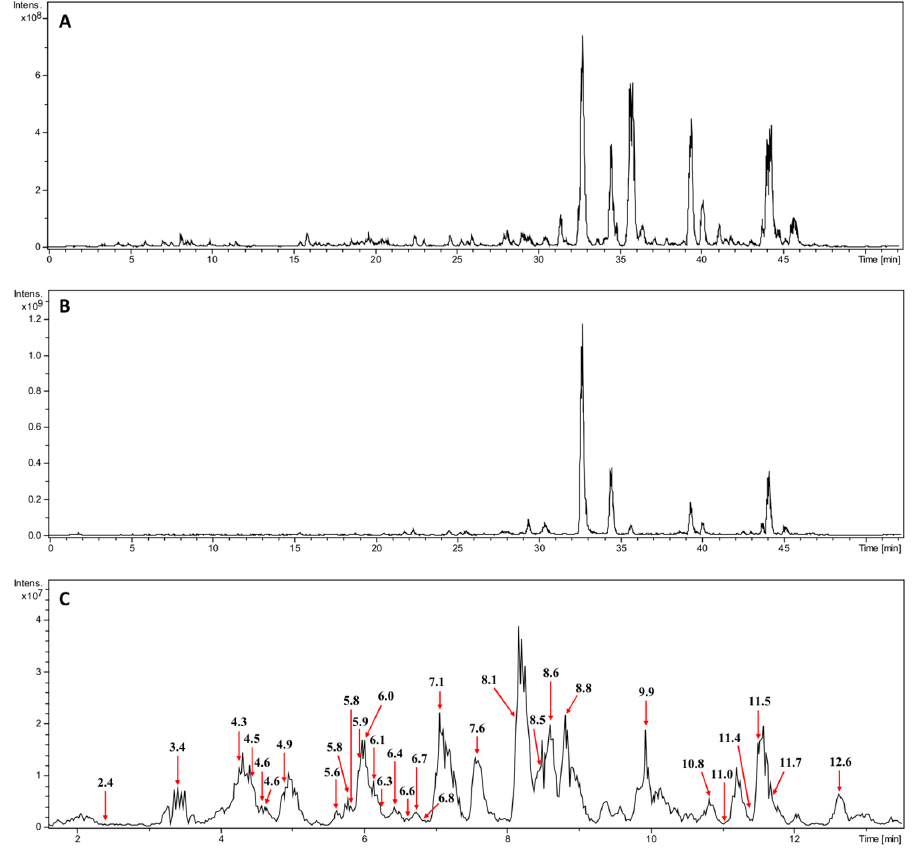
Figure 1. ( A ) The total ion chromatogram of acellular culture supernatant residues from X. fastidiosa 9a5c grown in XFM medium (UFLC-ESI-IT, in positive ion mode); ( B ) Negative control XFM medium; ( C ) The retention times of diketopiperazines were amplified.